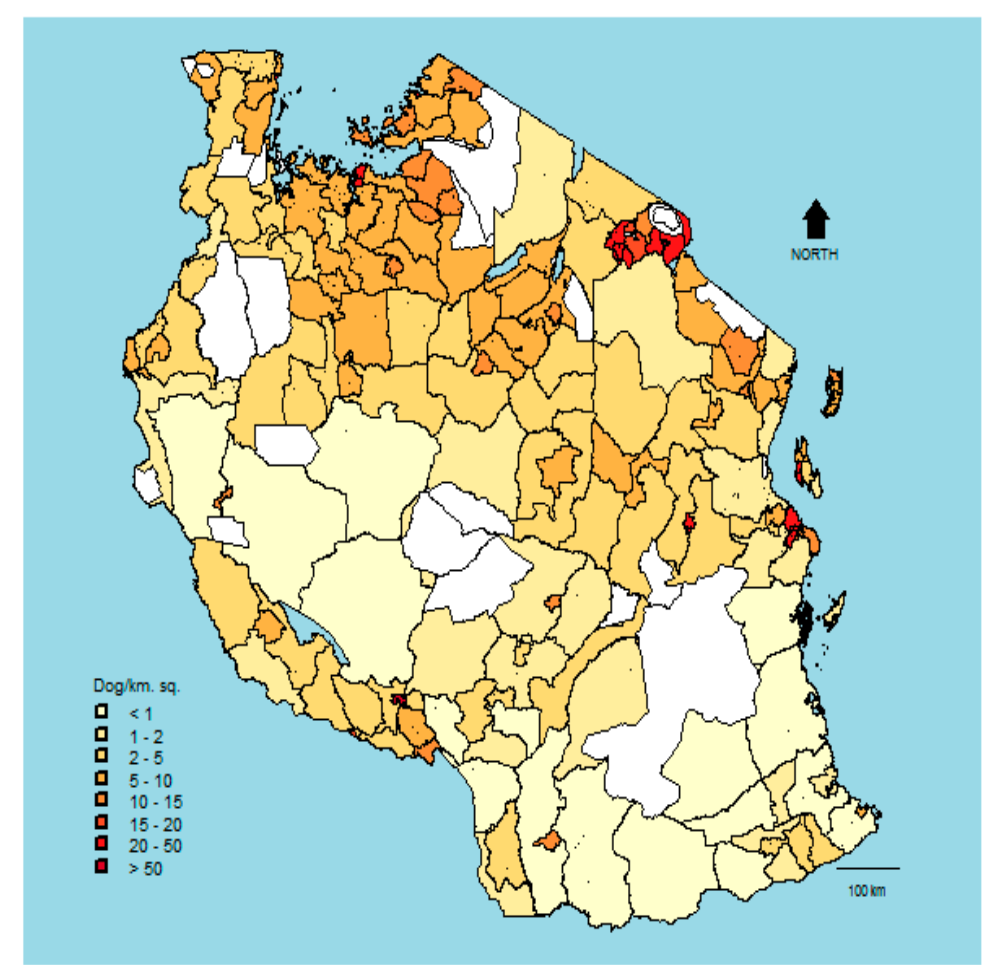
Figure 4. Estimated dog densities in districts across Tanzania. White areas represent water bodies, forest reserves, or wildlife-protected areas.